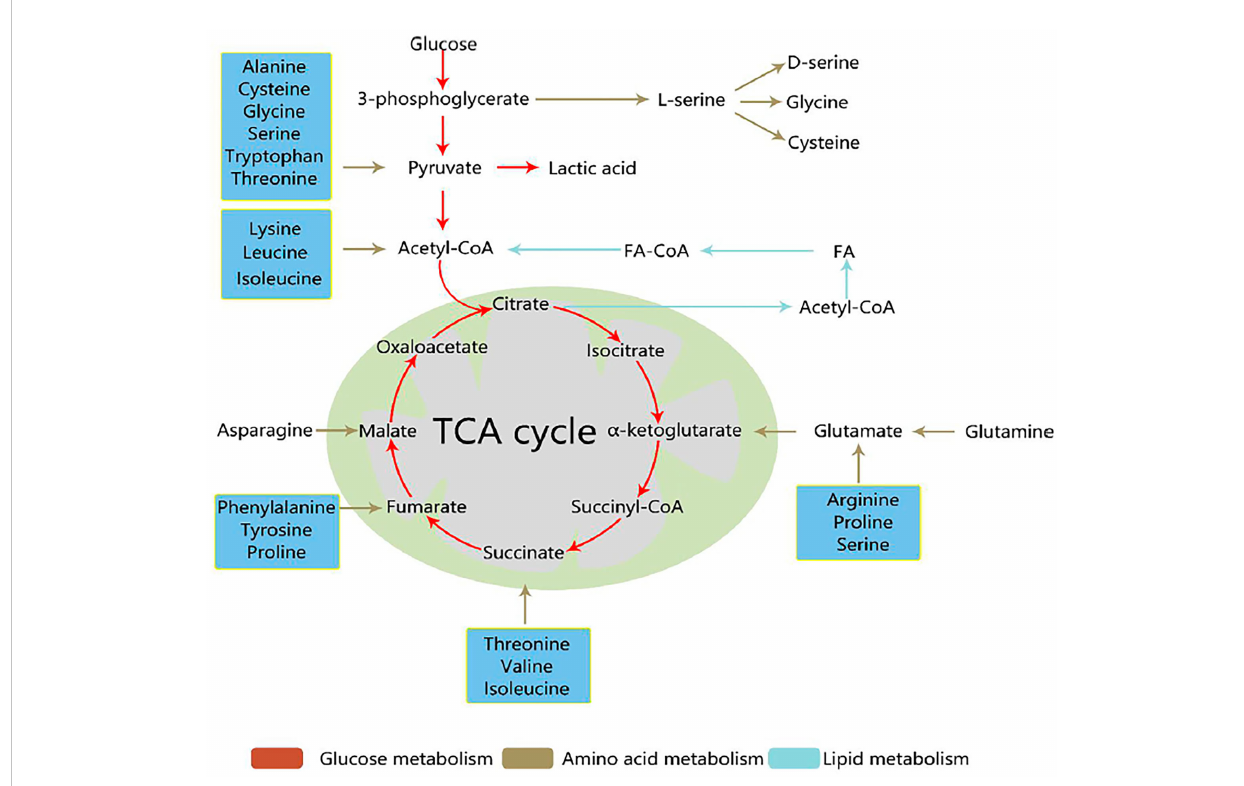
FIGURE 1 Three core metabolic pathways of cancer cells (9). Reprinted (adapted) with permission from Han, Li, Chen and Yang. (2021). Front Mol Biosci. 2021,8